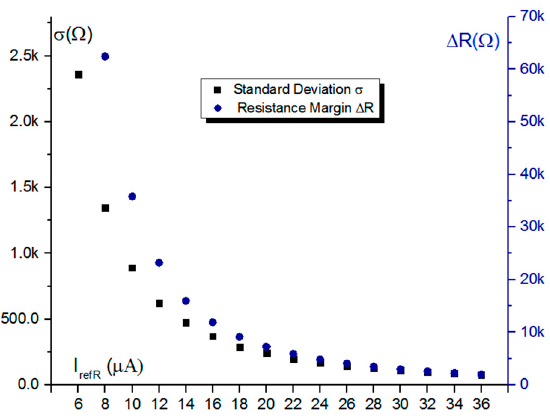
Figure 12. Standard deviation and resistance margin between HRS distributions for the 16 RST compliance currents presented in Table 3.